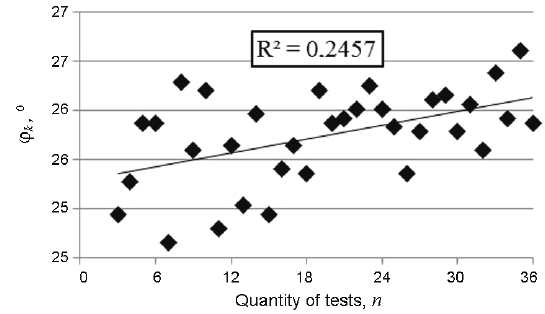
Fig. 10. Variations in the height of the soil sample during the shear test